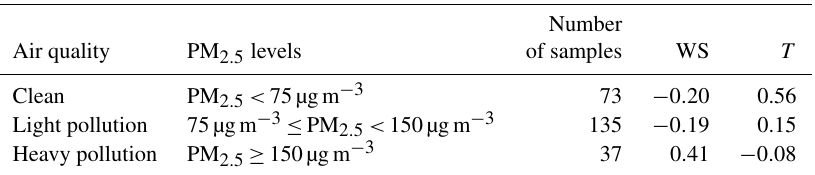
Table 2. Correlation coefficients of PM 2 . 5 concentrations with wind speed (WS) and air temperature ( T ) in different air quality levels during the study period.